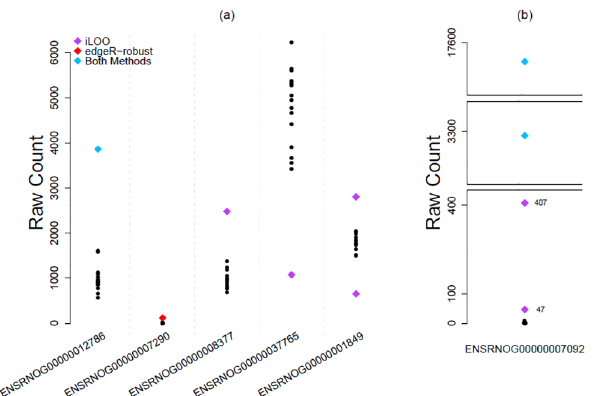
Fig 3. Scatterplot of read counts observed in real data for a sample of features. Scatterplot of raw counts for six representative features displaying counts identified as outliers by iLOO (purple diamond), edgeR-robust (red diamond), and both methods (blue diamond) in the control group of rat RNA-seq